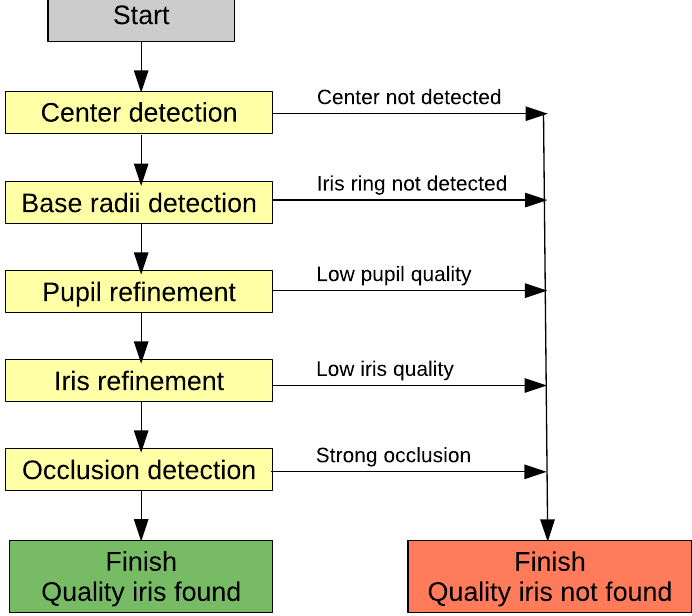
Figure 2. Workflow of iris segmentation